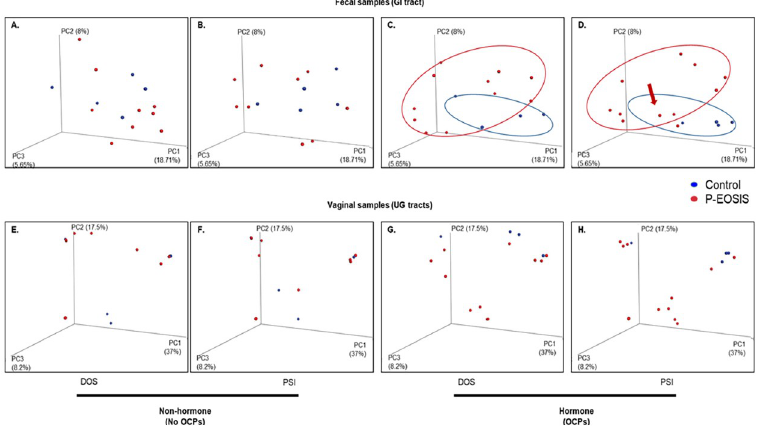
Fig 2. Principal Coordinates Analysis (PCoA). PCoA shows the distribution of GI (fecal samples) and UG (vaginal samples) bacterial communities on the day of surgery (DOS) and post-surgery intervention (PSI) for patients with endometriosis (P-EOSIS) and controls subjects (control) that were receiving or not receiving hormonal treatment (OCPs). PC1, PC2 and PC3 were plotted on the x, y and z axes. A., E . (DOS), B., F . (PSI): Non-hormone (fecal: n = 9, vagina: n = 14). C., G . (DOS), D., H . (PSI): Hormone (fecal: n = 20, vagina: n = 15).